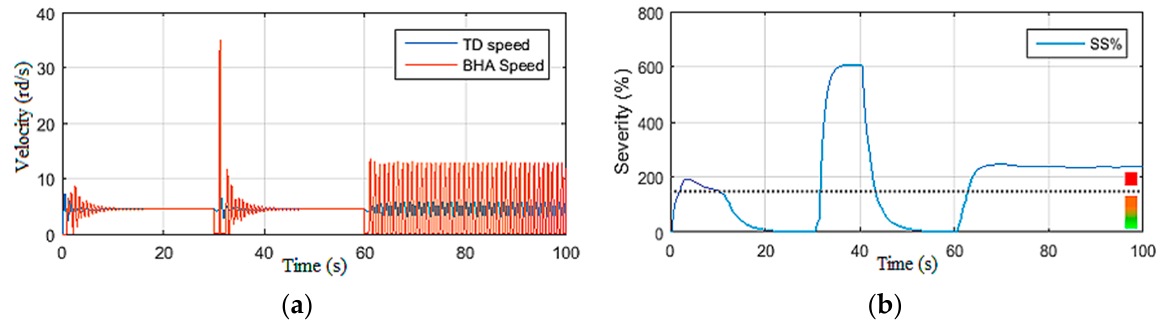
Figure 7. Outputs of Scenario 2: ( a ) drill bit velocity; ( b ) stick-slip severity.